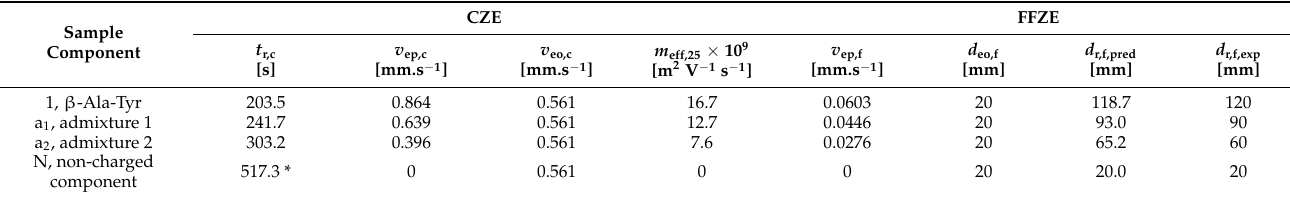
Table 2. Migration times, electrophoretic and electroosmotic velocities, effective mobilities and predicted and experimental distances of β -Ala-Tyr, its admixtures a 1 and a 2 and the noncharged component N separated by CZE and FFZE. Sample